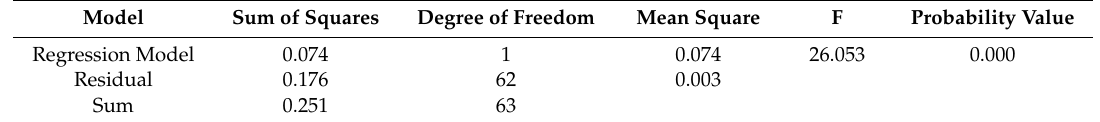
Table 5. The Analysis of Variance between Ship Capacity (TEU) and Draft.